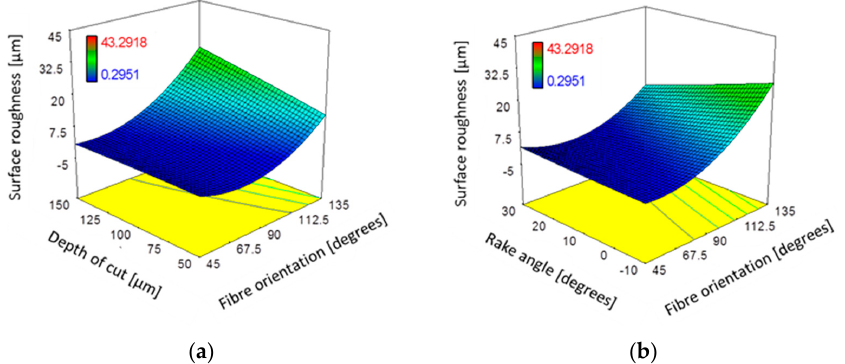
Figure 20. The combined effect on surface roughness ( R a ) of ( a ) depth of cut and fibre orientation at constant α : 10°; V c : 57 mm/min; and ( b ) fibre orientation and tool rake angle at constant DOC: 100 µm; V c : 570 mm/min.